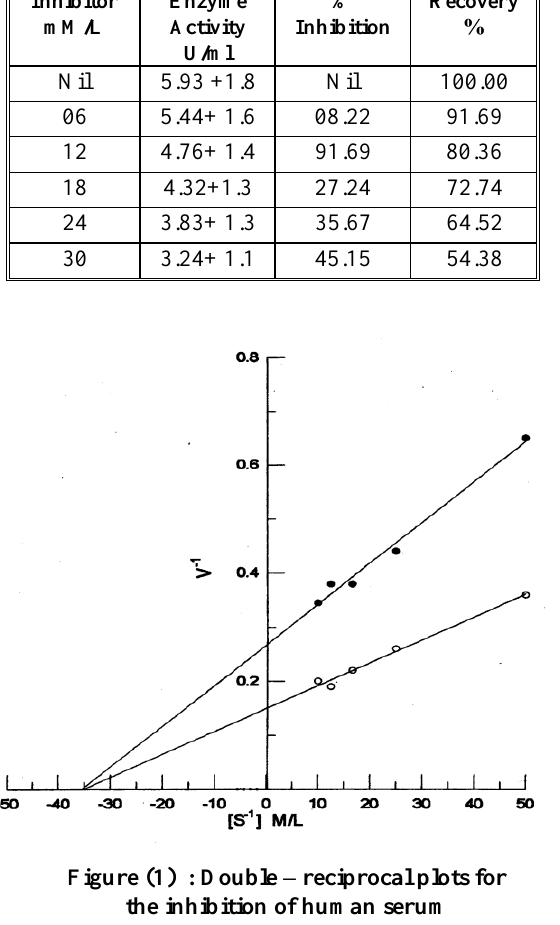
Figure (1) : Double – reciprocal plots for the inhibition of human serum cholinesterase in the presence (●) and absence of (o) of 30 mM/L gallic acid . Acetylthiocholin iodide concentrations (s) were ; 0.02, 0.04 ,0.06 ,0.08 , 0.10 M/L